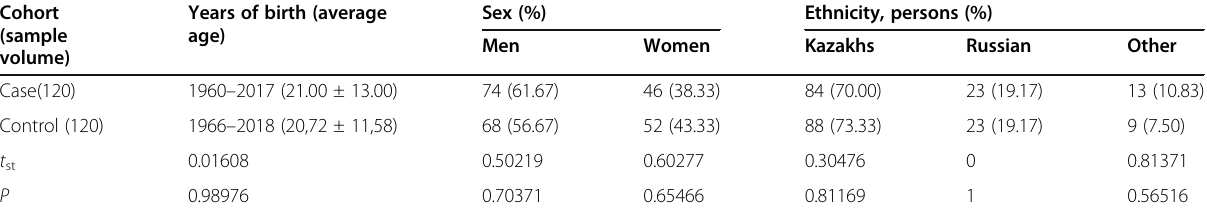
Table 3 The main characteristics of studied cohorts Cohort (sample